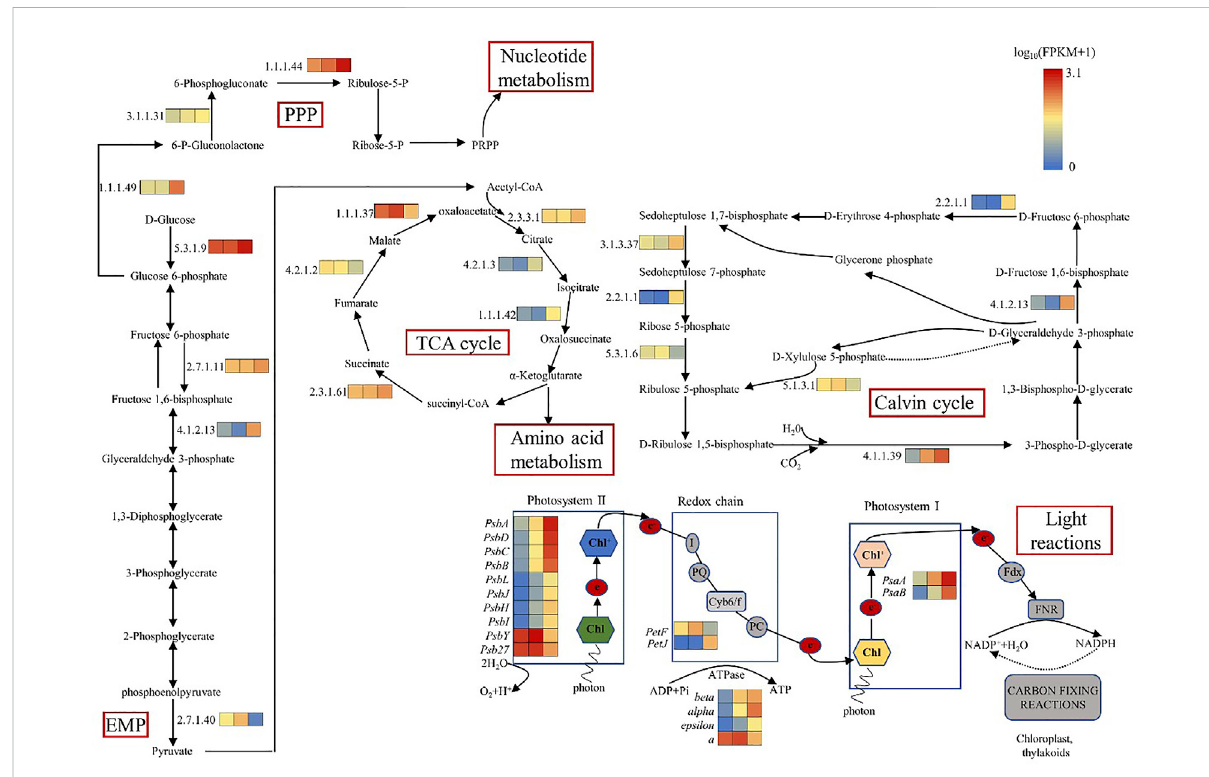
FIGURE 3 Changes in transcription levels of key enzymes in major metabolic